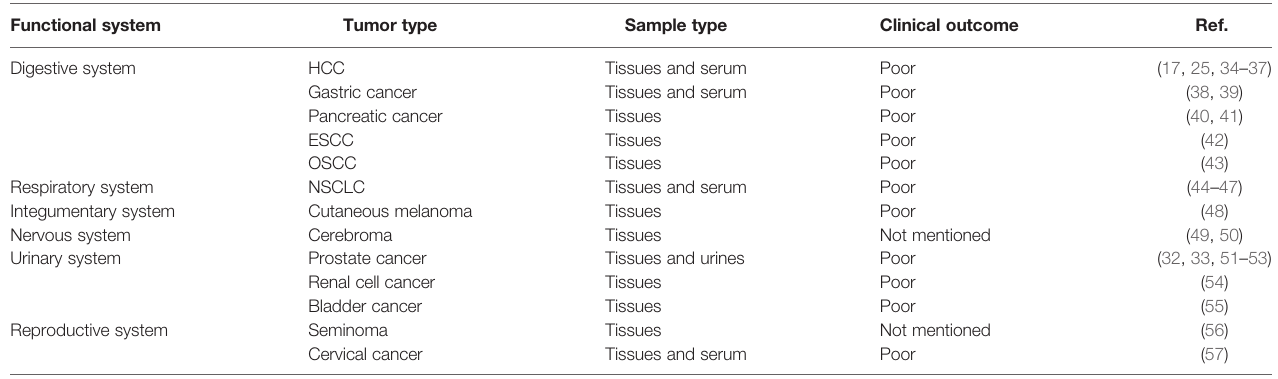
TABLE 1 | GP73 is highly expressed in pathological tissues and serum derived from cancer patients. Functional system Tumor type Sample type Clinical outcome Ref.